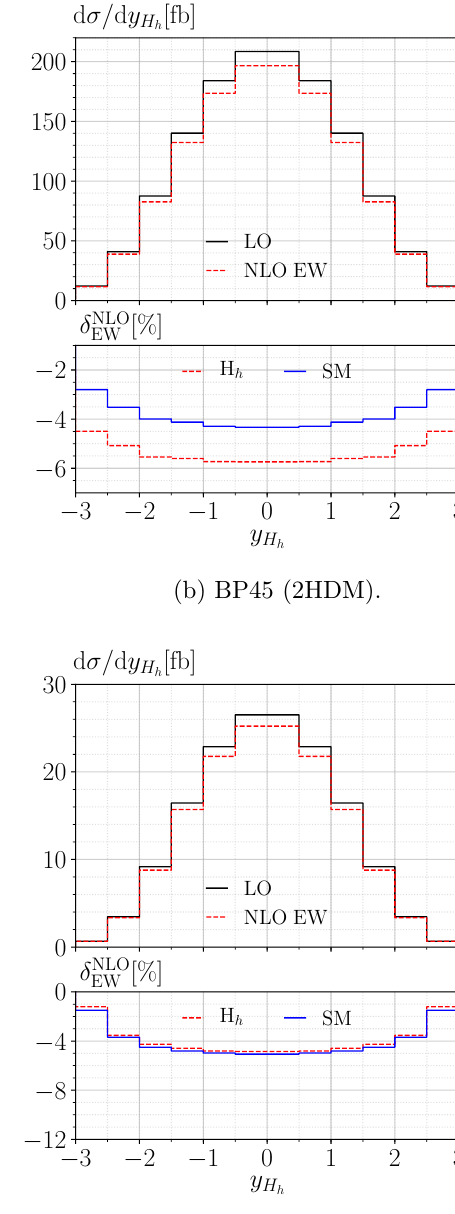
H h for heavy Higgs production in VBF